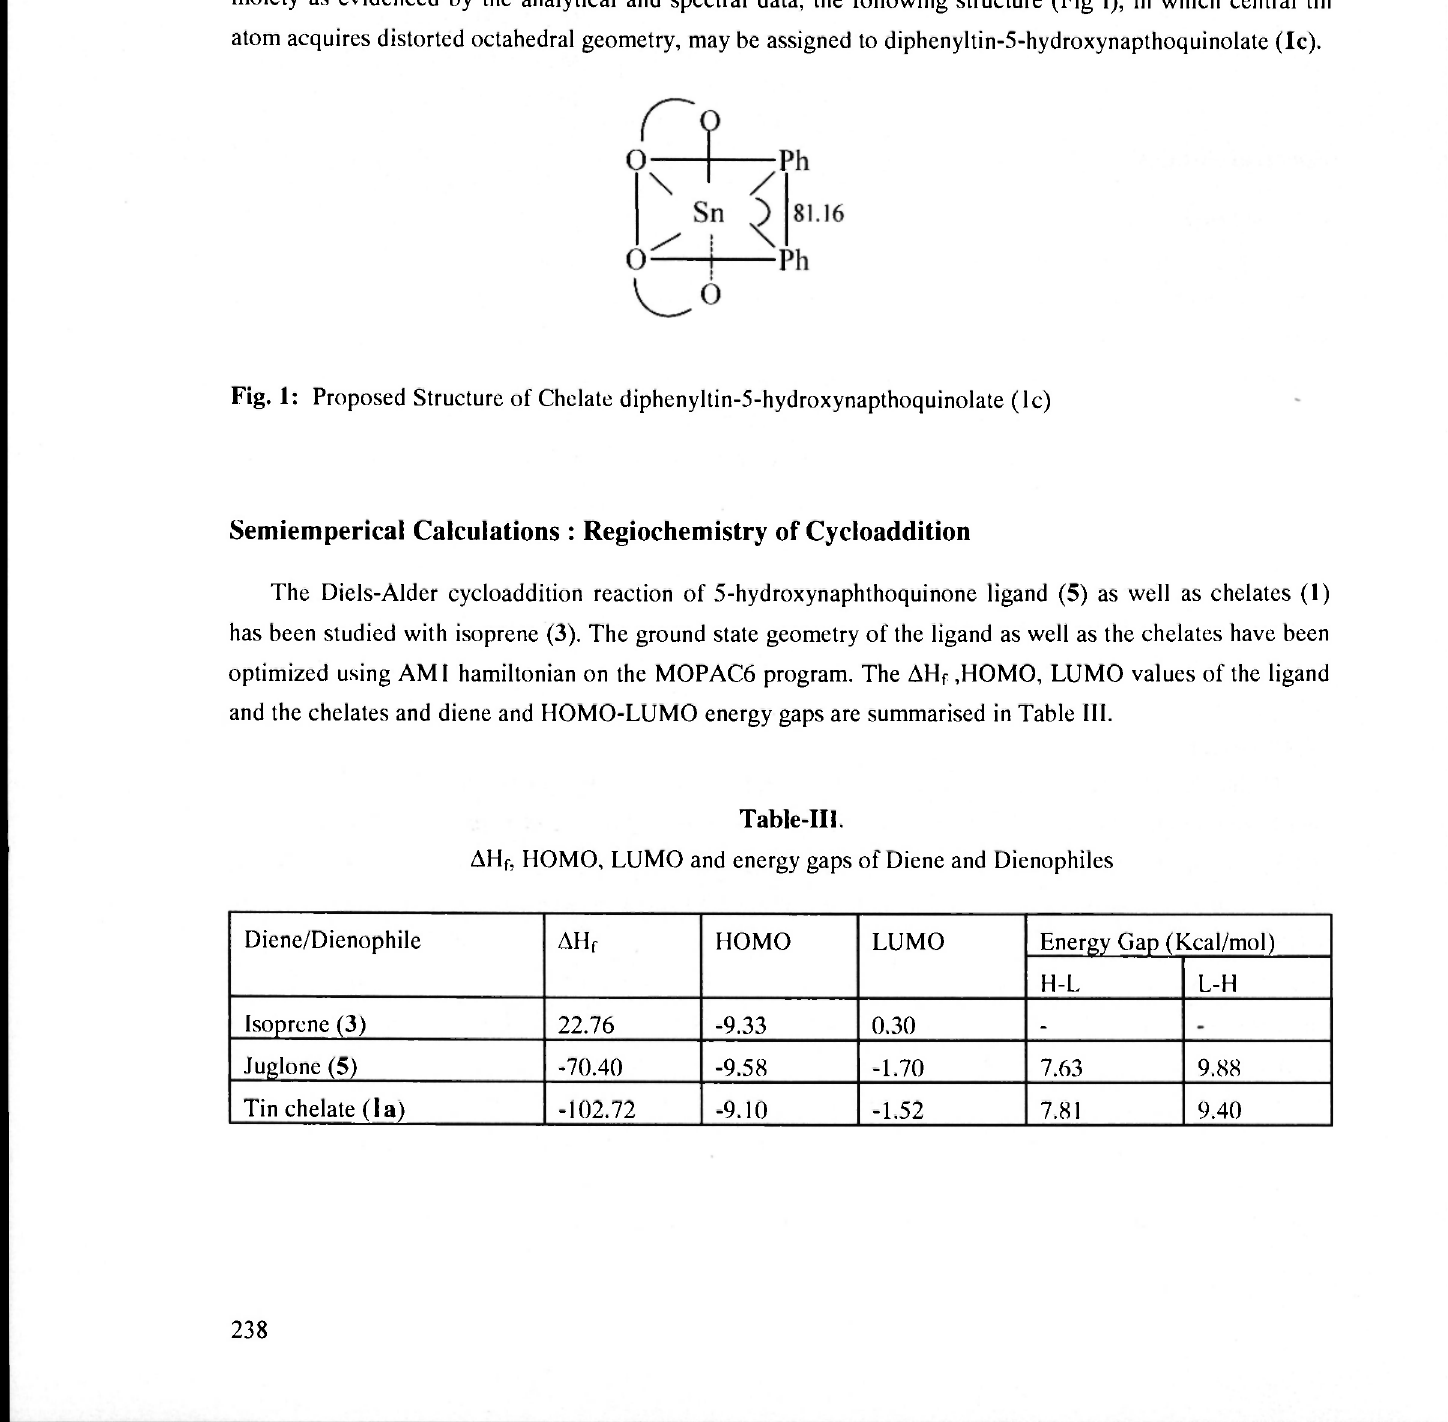
Fig. 1: Proposed Structure of Chelate diphenyltin-5-hydroxynapthoquinolate (lc)